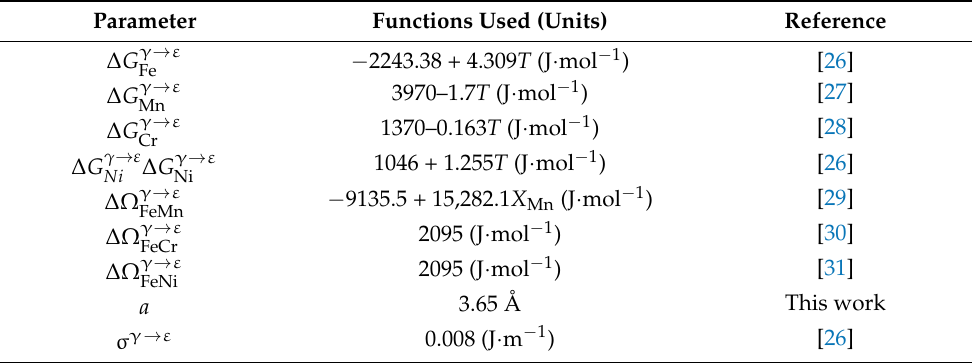
Table 1. Numerical values and functions used for the calculations.